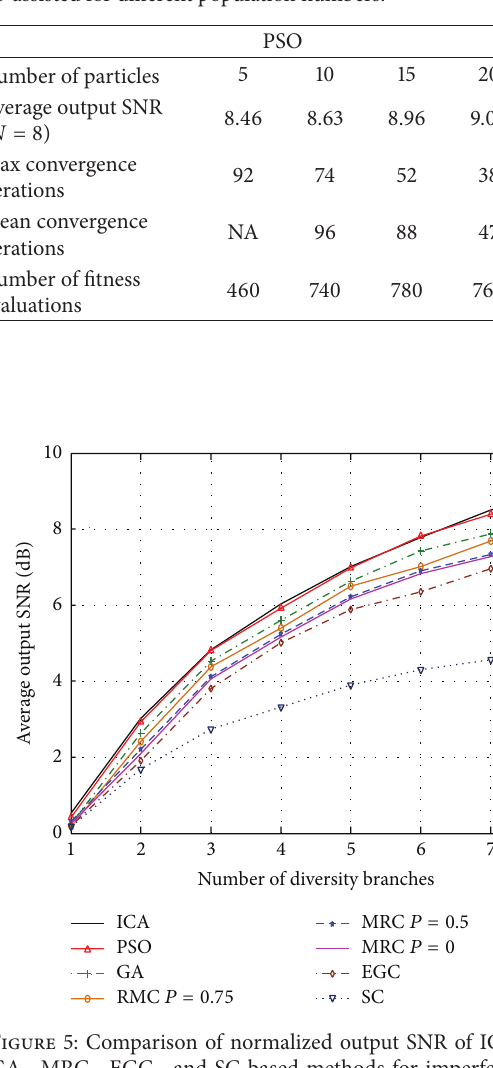
Table 3: Performance comparison of ICA and PSO assisted for different population numbers.